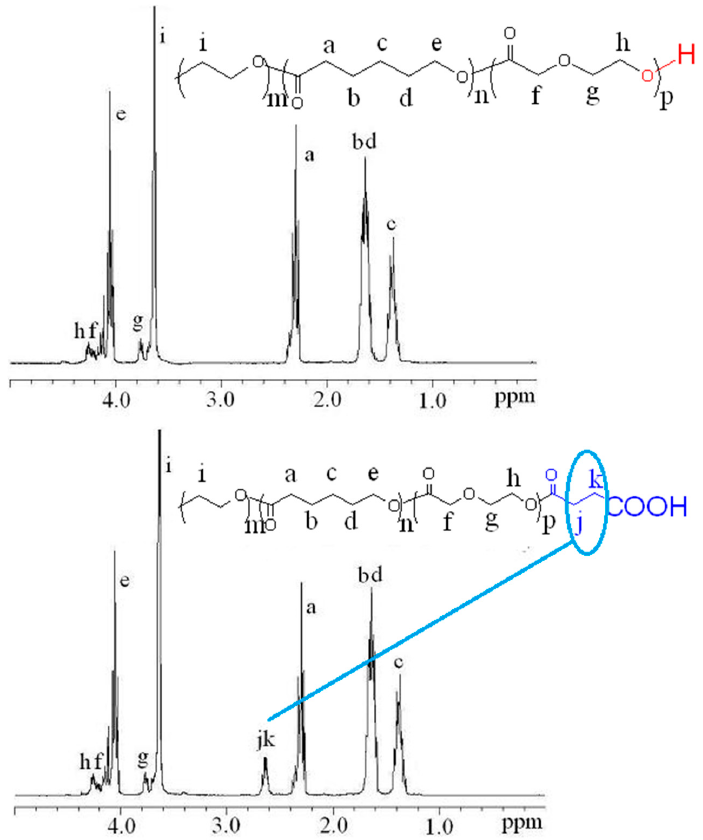
Figure 2. 1 H NMR spectra of PECP copolymers with hydroxyl ( Upper ) and carboxylic ( Lower ) end groups.